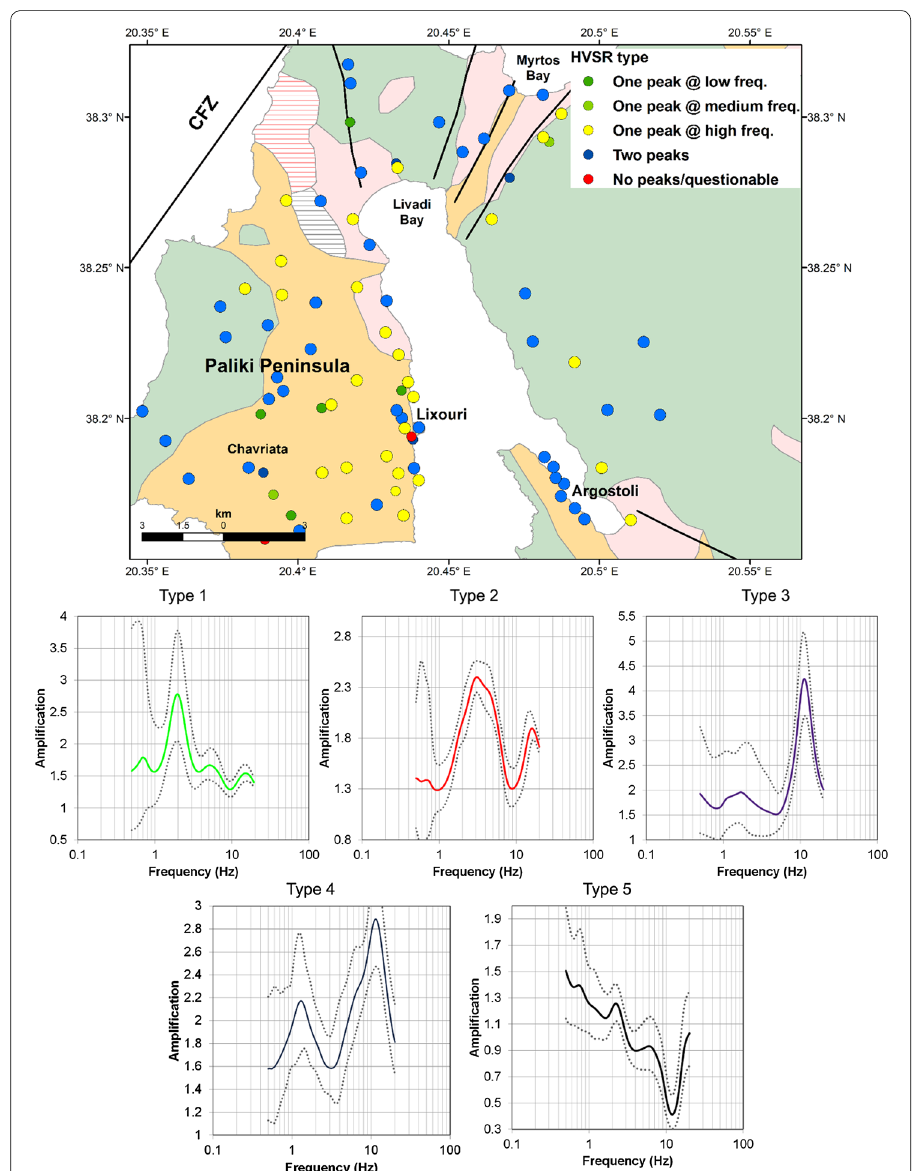
Fig. 4 Top Spatial distribution of the 5 HVSR curves typologies based on their shape characteristics. The leg- end for the geological settlement is presented in Fig. 2. Bottom Examples for each HVSR typology. Solid and dashed lines represent the logarithmic average of the HVSR and its standard deviation,